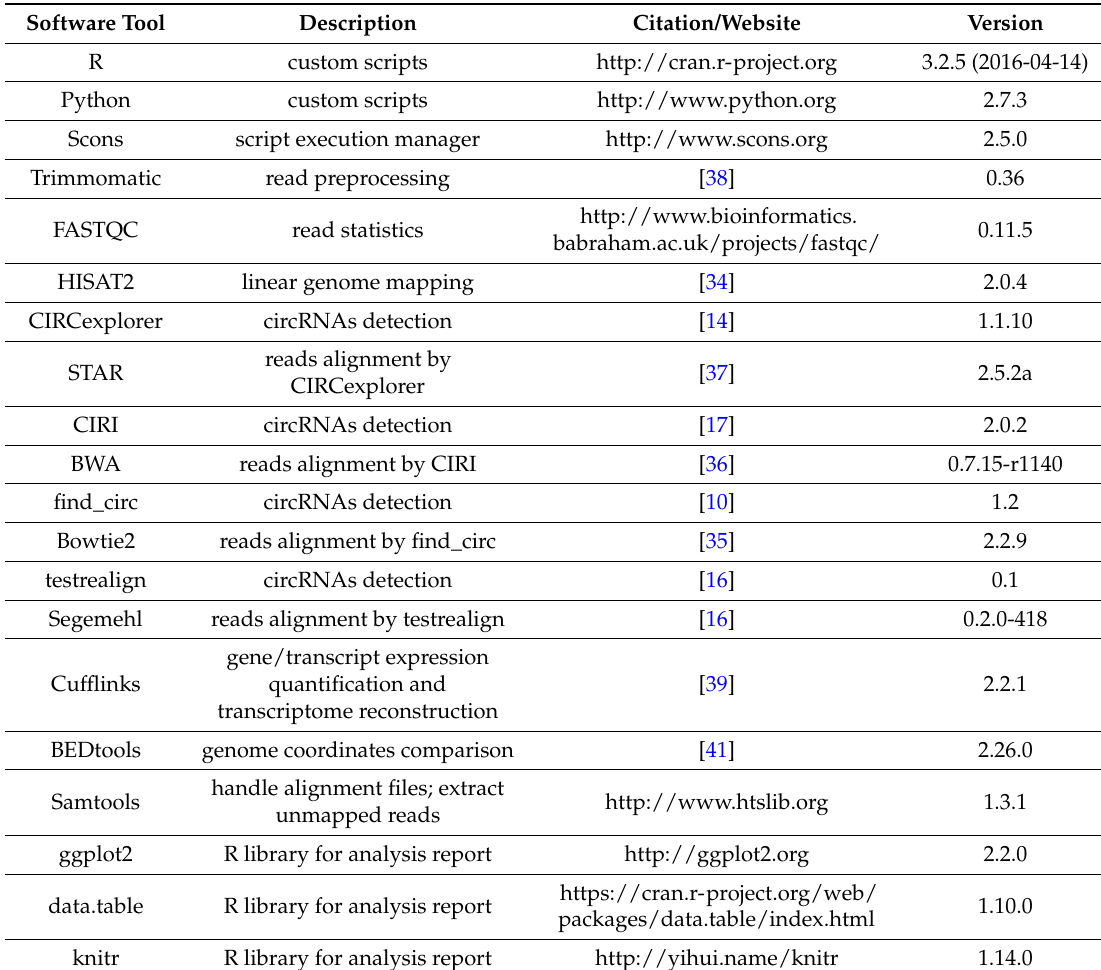
Table 2. List of the main software tools included in CirComPara with description of their function, and